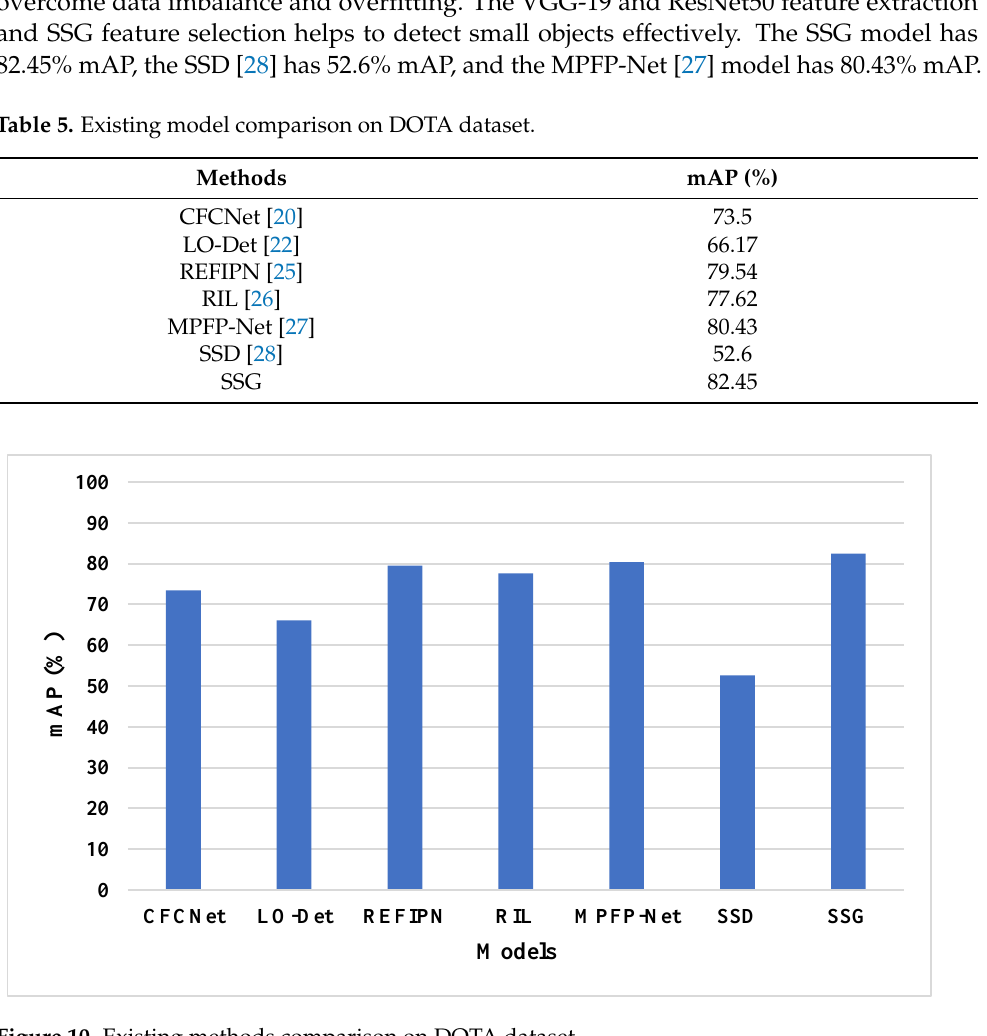
Figure 10. Existing methods comparison on DOTA dataset.